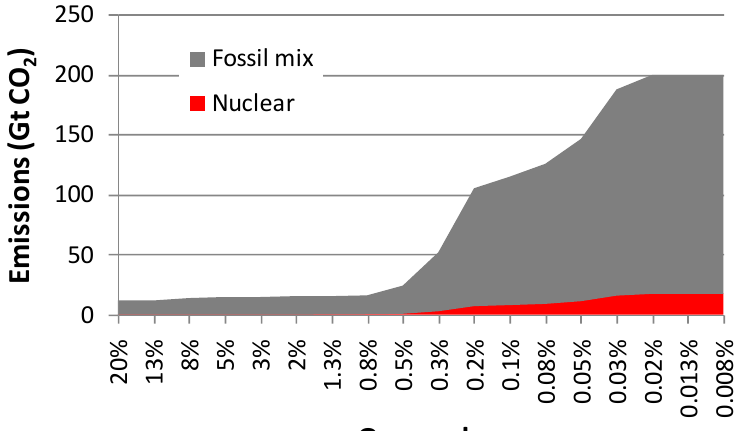
Figure 23. Cumulative greenhouse gas emissions associated with the generation of the electricity equivalent in Figure 17, from ores with decreasing ore grades, using nuclear power plants (red), and as an alternative the 2006 mix of coal (61%), oil (9%) and gas (30%) plants